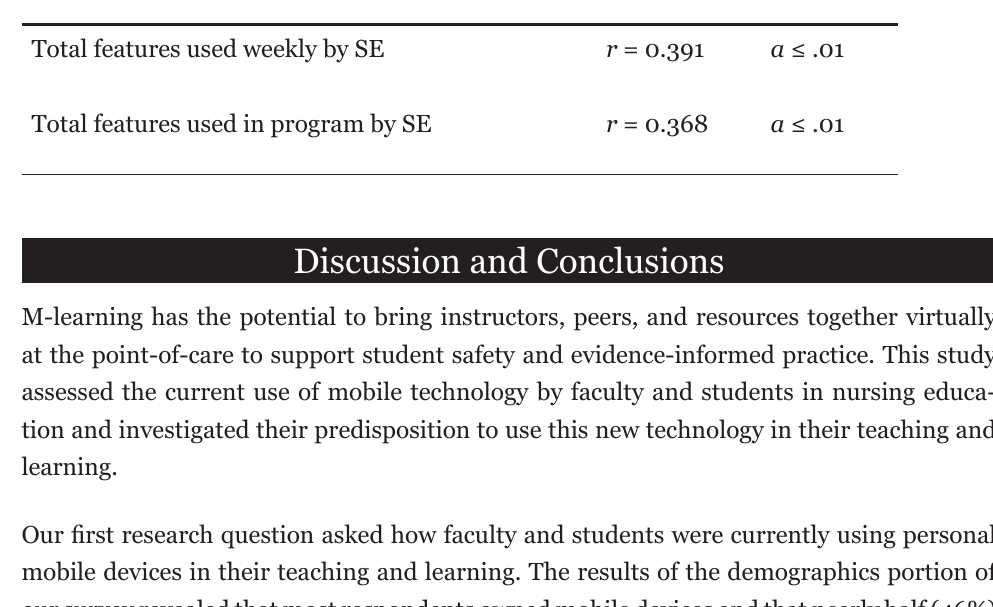
Number of Mobile Features Use and